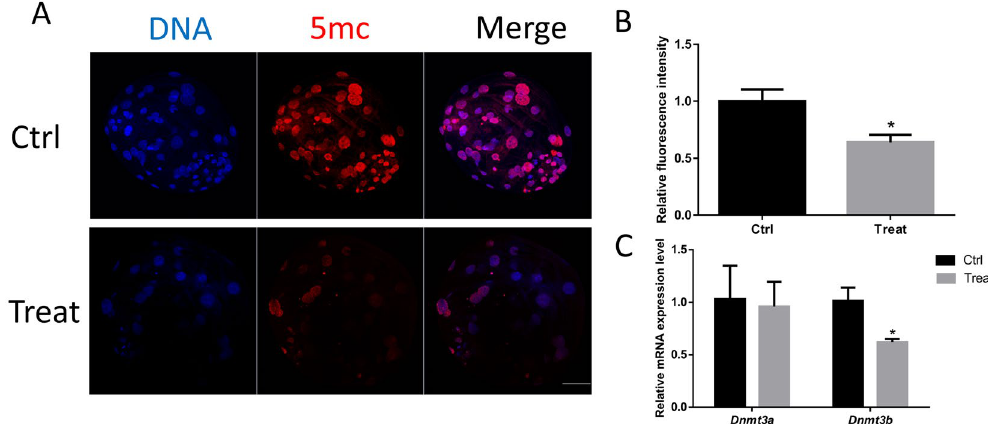
Figure 7. BPA exposure results in the alternations of methylation. ( A ) Immunostaining for 5 mC was detected between the control and BPA treatment groups. ( B ) Relative fluorescence intensity of 5 mC is shown as bars. * P < 0.05. Ctrl, control; Treat, treatment. Scale bar: 50 μ